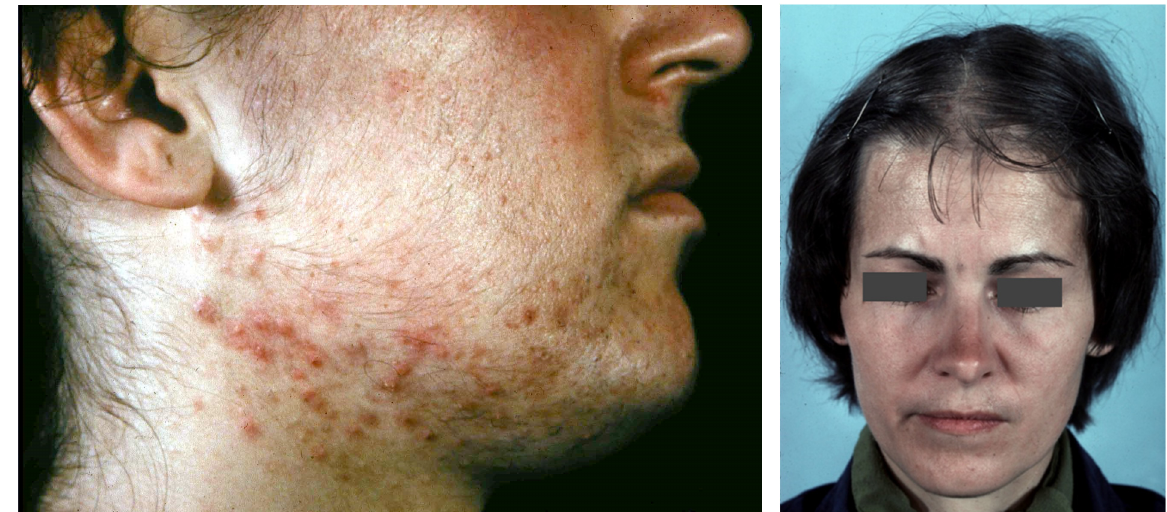
Figure 2. Acne, hirsutism and androgenetic alopecia of female pattern in PCOS patients.